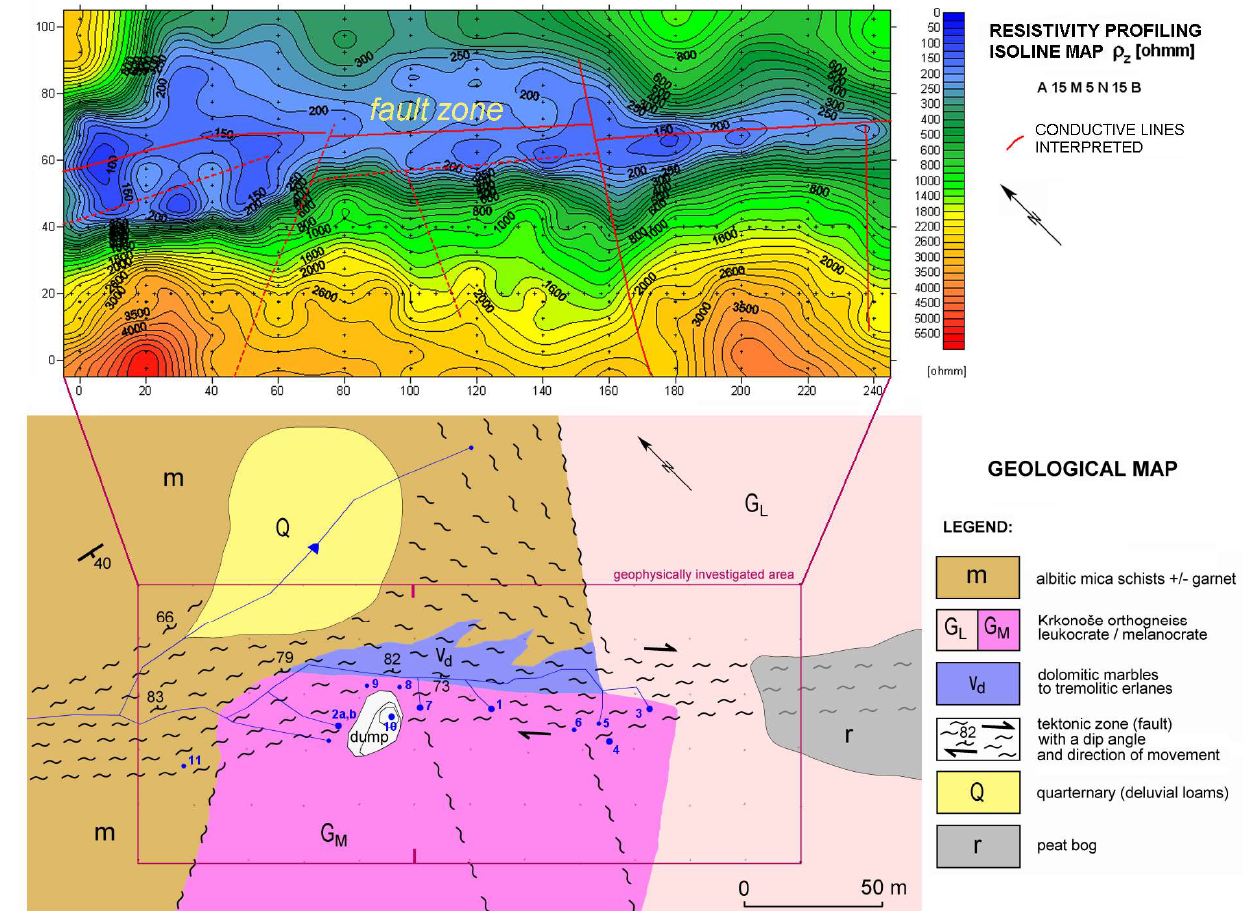
Figure 9. A detailed hydrogeological situation of Sv. Vojtěch spring in Horní Malá Úpa, Krkonoše. Outflows of 11 springs HMÚ-1 to 11 were localized in the line of the highest resistivity gradient, i.e., on the edge of the clay fill of the fault zone. Modified from